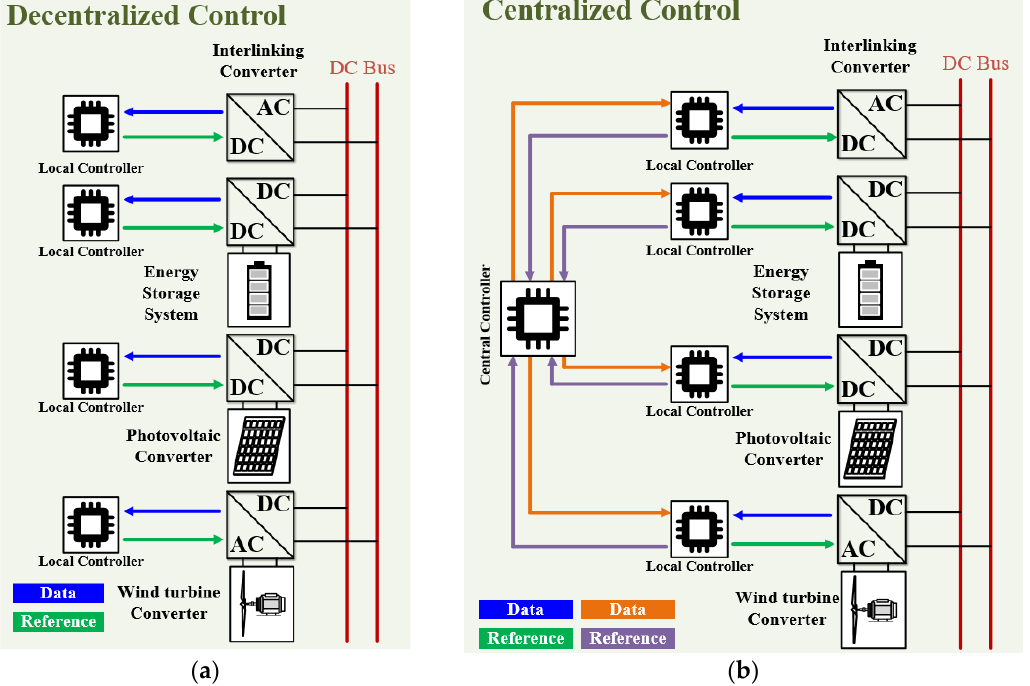
Figure 2. Microgrid control methods: ( a ) distributed system; ( b ) centralized system.